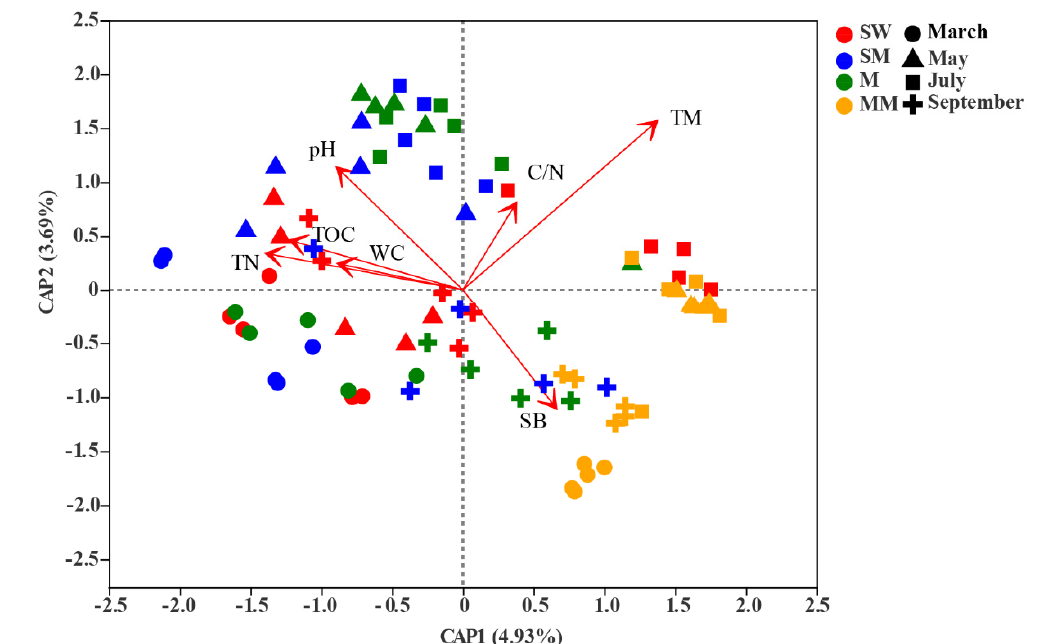
Figure 5. Distance-based redundancy analysis (db-RDA) of bacterial communities in all soil samples. The values of axes 1 and 2 are the percentages explained by the corresponding axis. TN is soil total nitrogen, WC is soil water content, SB is shoot biomass, TOC is soil total organic carbon, TM is soil temperature. SW is swamp wetland, SM is swamp meadow, M is meadow, MM is mature meadow.